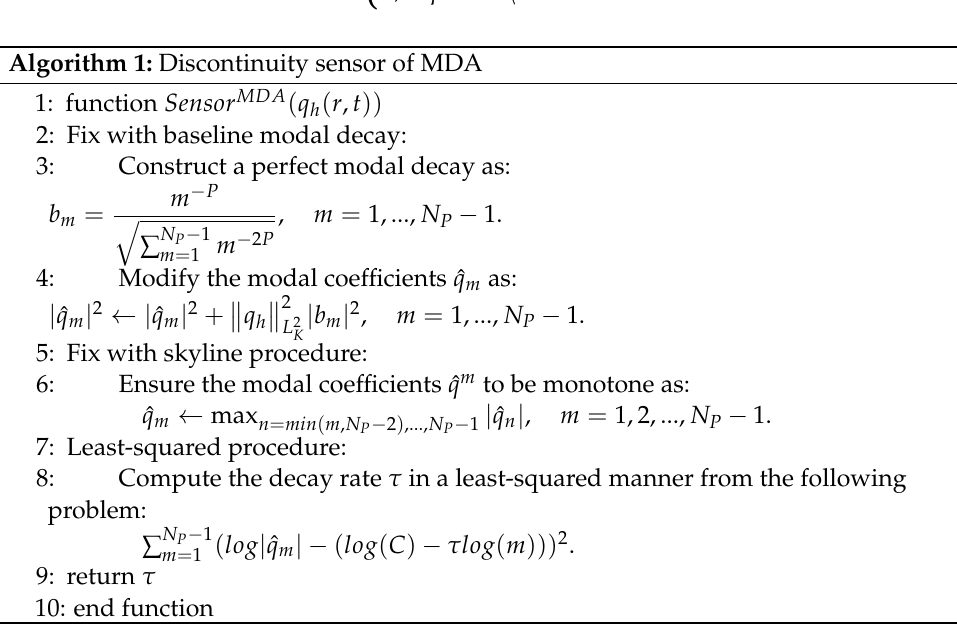
Algorithm 1: Discontinuity sensor of